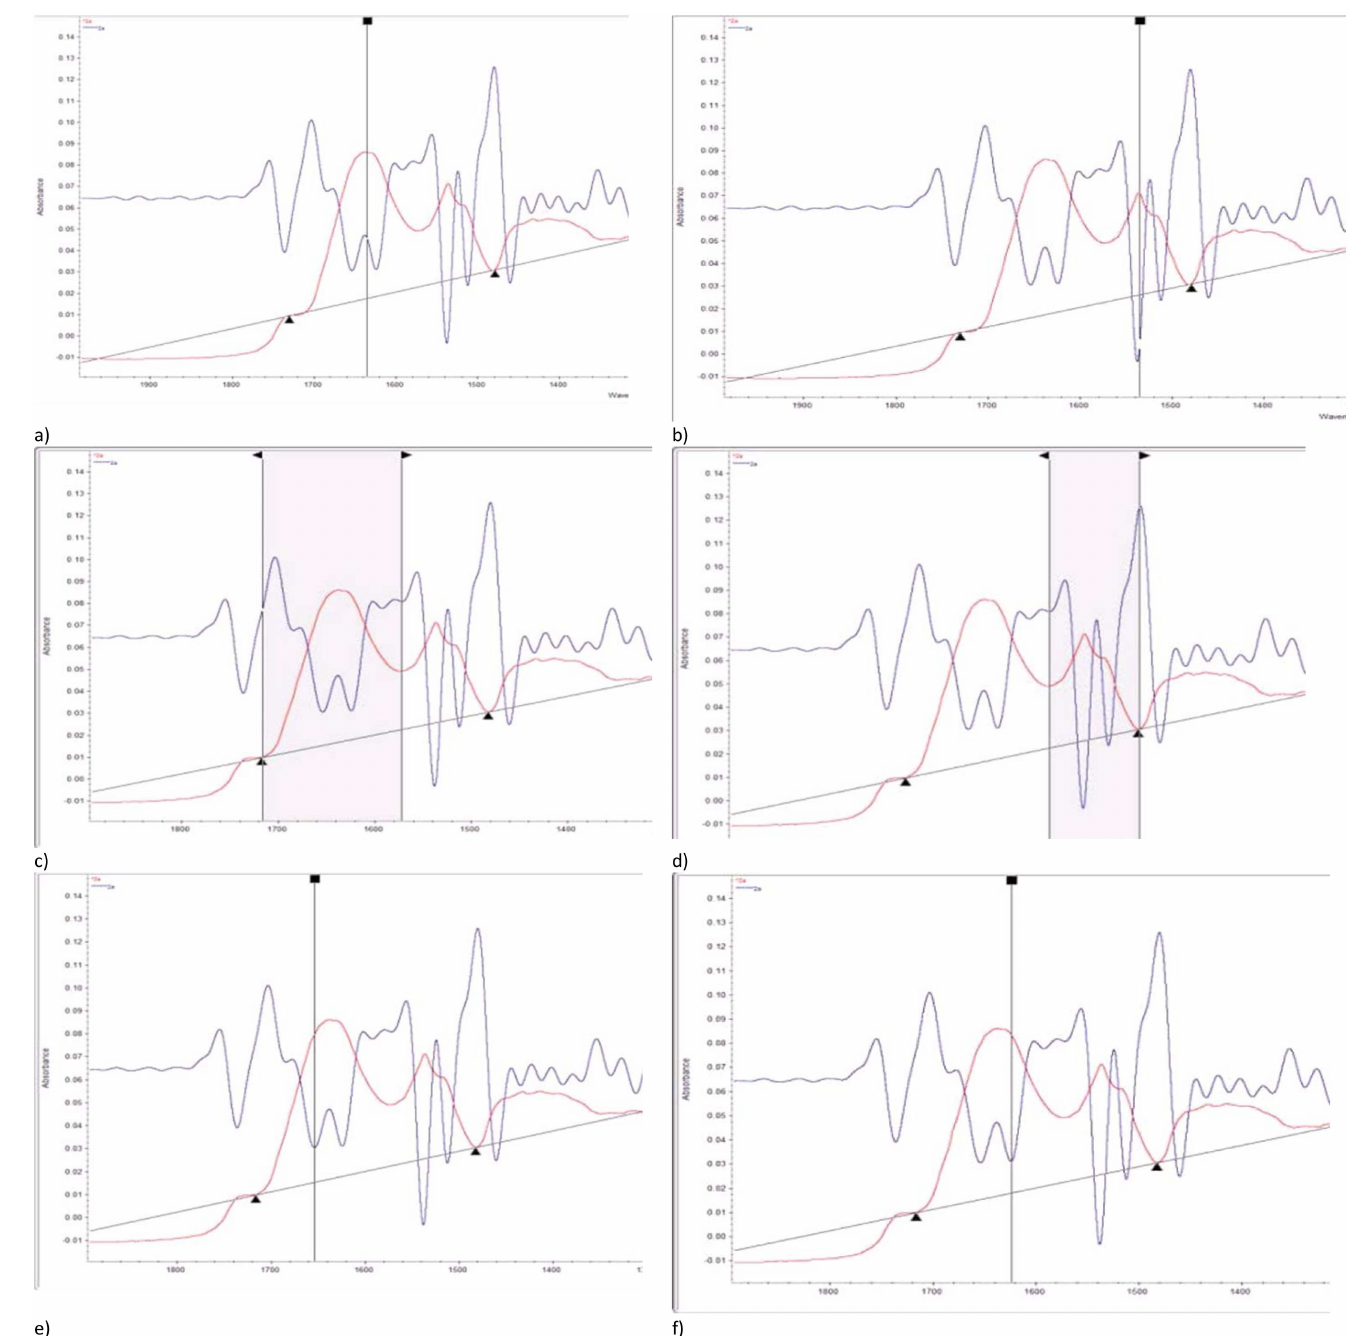
Fig 1. Typical FTIR spectrum for co-products from bio-oil processing at the regions of protein (ca. 1718–1481cm -1 ). a) amide I height; b) amide II height; c) amide I area; d) amide II area; e) α -helixheight; f) β -sheet height.